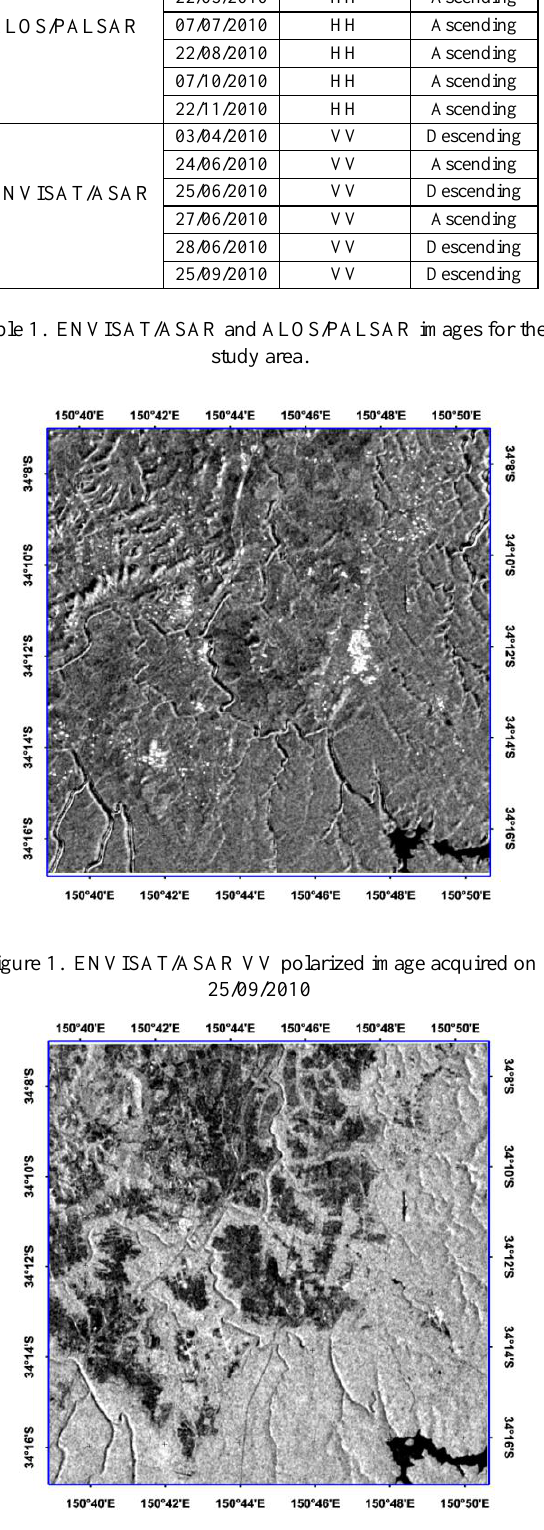
Figure 2. ALOS/PALSAR HH polarized image acquired